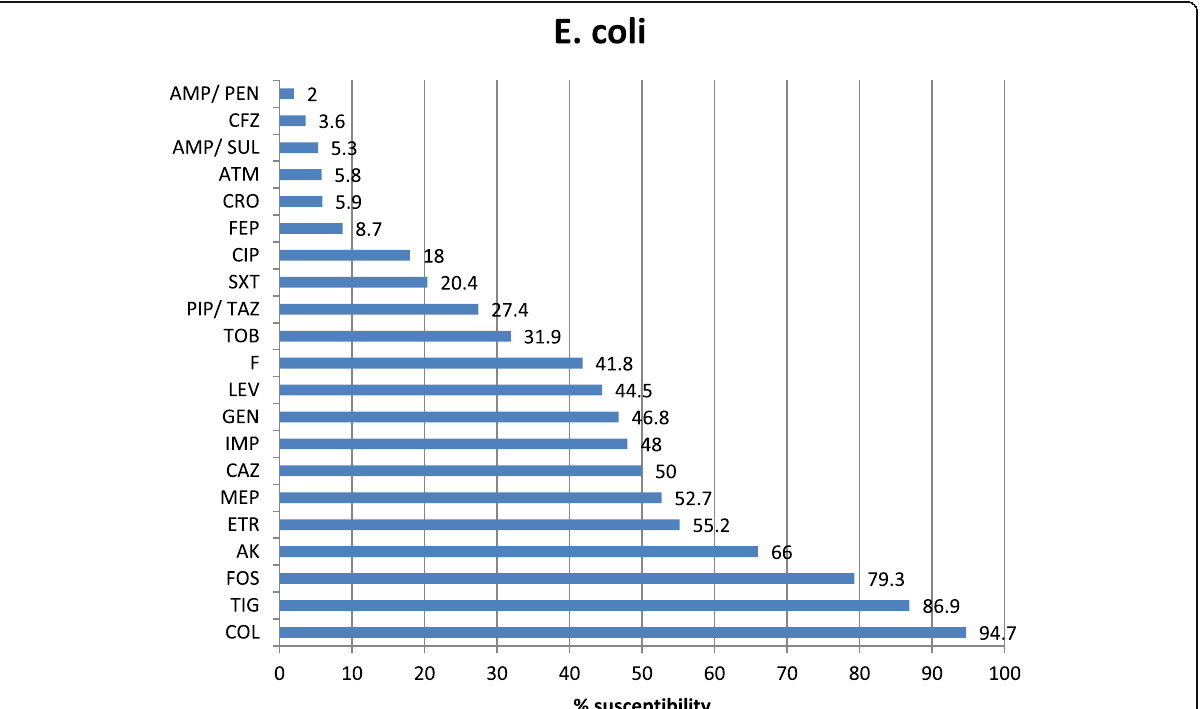
Fig. 3 Antibiotic susceptibility of Escherichia coli . E. coli Escherichia coli , AMP/PEN ampicillin/penicillin, CFZ cefazolin, FEP cefepime, CRO ceftriaxone, AMP/SUL ampicillin/sulbactam, F nitrofurantoin, PIP/TAZ pipracillin/tazobactam, CIP ciprofloxacin, ATM aztreonam, TOB tobramycin, CAZ ceftazidime, SXT sulfa-trimethoprim, MEP meropenem, IMP imipenem, ERT ertapenem, GEN gentamycin, AK amikacin, LEV levofloxacin, FOS fosfomycin, TIG tigecylcine, COL